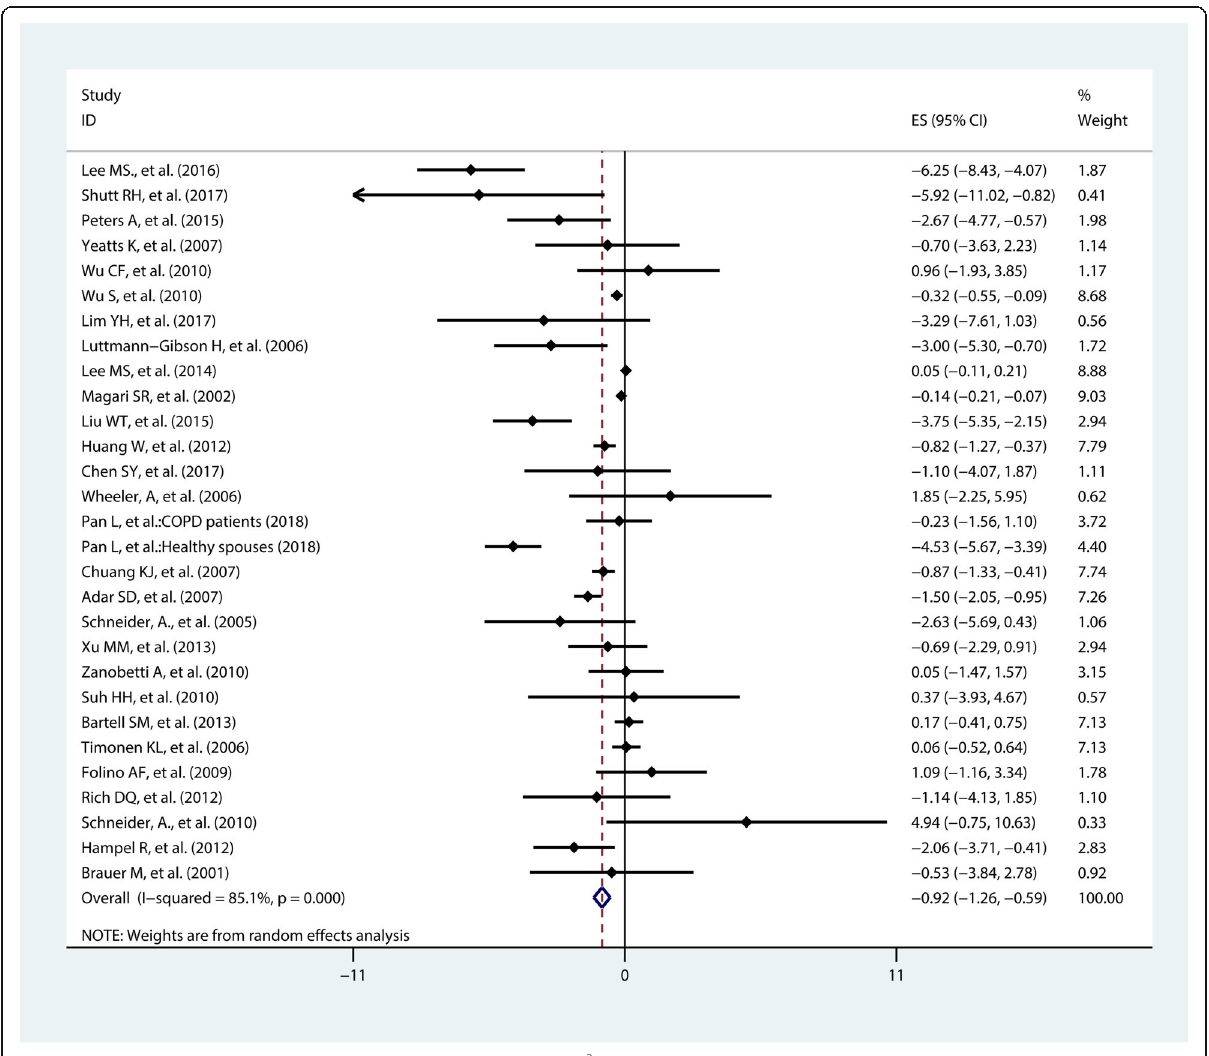
Fig. 2 Pooled percent change (%) of SDNN associated with a 10 μ g/m 3 increase of PM